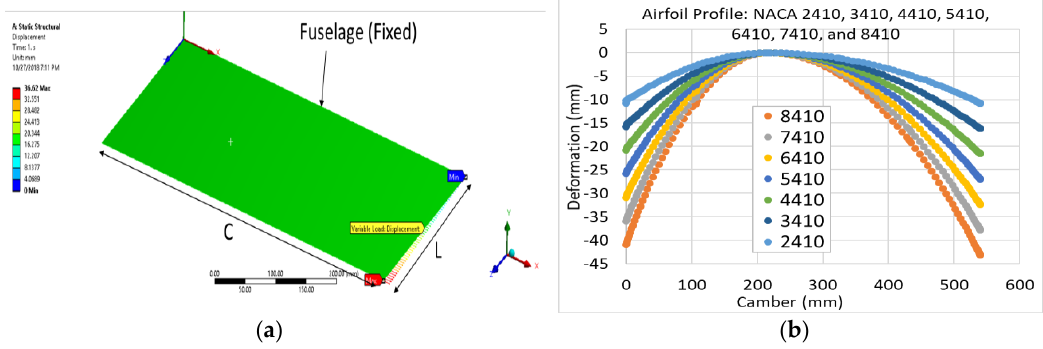
Figure 9. ( a ) Acrylonitrile Butadiene Styrene (ABS) 2D-plate model and ( b ) NACA profiles.